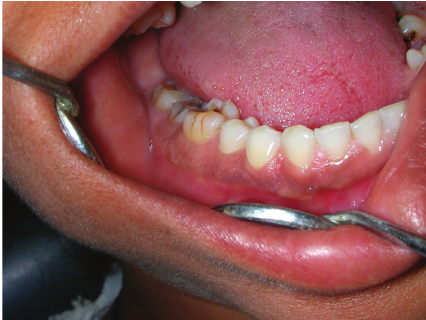
Figure 3: Intraoperative view shows expansion of the underlying buccal cortex with a bluish tinged surface is seen.